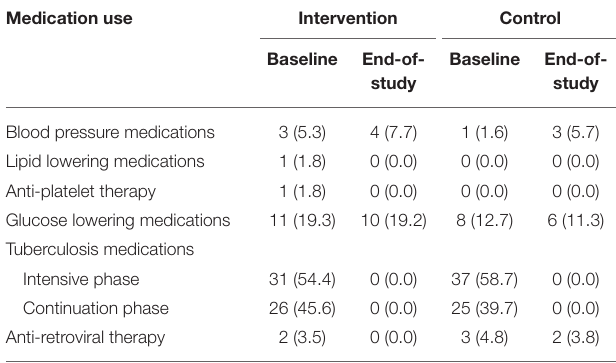
TABLE 4 | Medication use at baseline and